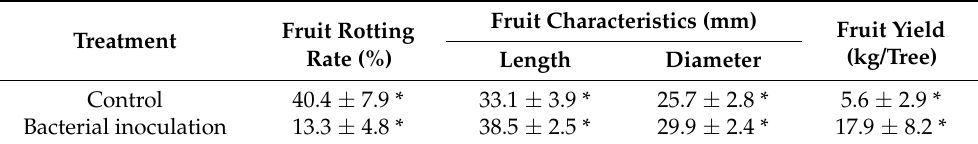
Table 1. Average jujube fruit rotting rate, length, diameter, and yield of jujube fruit in three standard trees with or without treatment with B. licheniformis PR2.